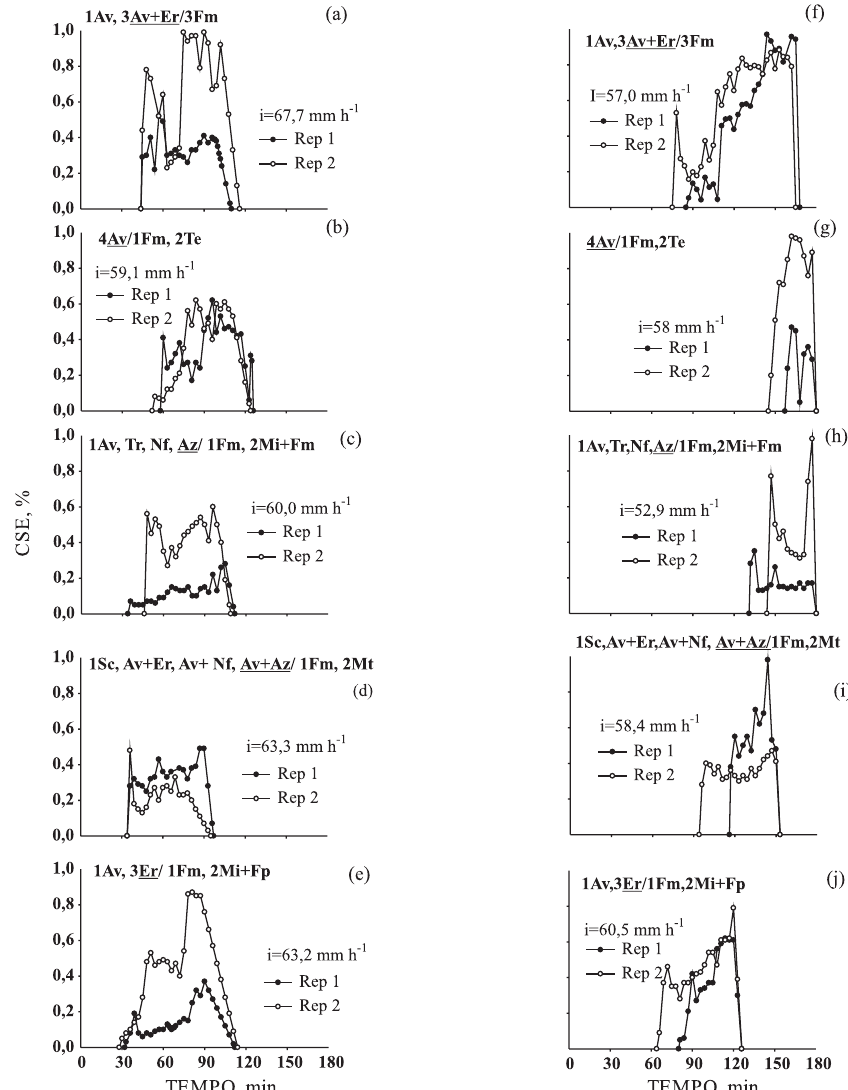
Figura 5. Concentrações instantâneas de sedimento na enxurrada (CSE) no quinto (T5: solo previamente escarificado – em T4 -, raízes mortas, 18 % coberto – figuras (a) a (e), à esquerda) e no sexto (T6: solo recém-gradeado – após T5 -, 0 % coberto – figuras (f) a (j), à direita) teste de erosão com chuva simulada, nas sequências culturais estudadas (Av: aveia-preta, Er: ervilhaca, Fm: feijão-miúdo, Te: teosinto, Tr: trevo-calypso, Nf: nabo forrageiro, Az: azevém, Mi: milho, Sc: sem cultivo, Mt: milheto e Fp: feijão-de- porco). Valores individuais para cada repetição dos tratamentos (Rep 1 e Rep